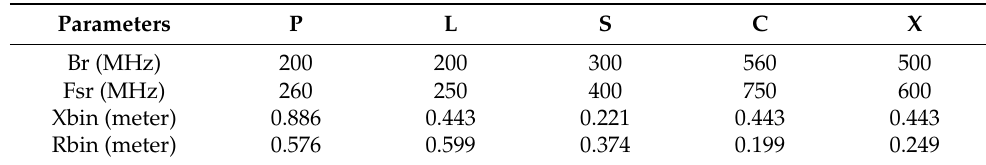
Table 1. Basic parameters of each band’s SAR data.